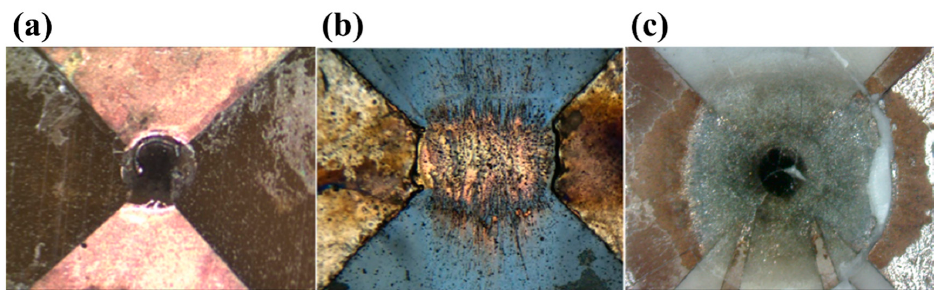
Figure 10. Images of the bridge foil electric explosion (2.0 kV): ( a ) Sample A, ( b ) Sample B, and ( c ) Sample C. As shown in Figure 10, the electric explosion occurred locally in the center of the bridge area of Sample A, and there were traces of electric explosion in the center of the bridge area. However, a large number of metal bridge foils still existed. In the bridge area of Sample B, the electric explosion occurred completely, except that some metal copper slag existed. In the bridge area of Sample C, the electric explosion was relatively complete, with only a small amount of residue, and the explosion trace was obvious. During the electrical explosion of the metal bridge foil, due to the size of the bridge area being small and the loaded pulse current being kA level, the current density flowing through the bridge area is relatively concentrated. When the grains of the bridge foil are not uniform and there are many pores and cracks in the Cu microparticles, the reaction in the middle